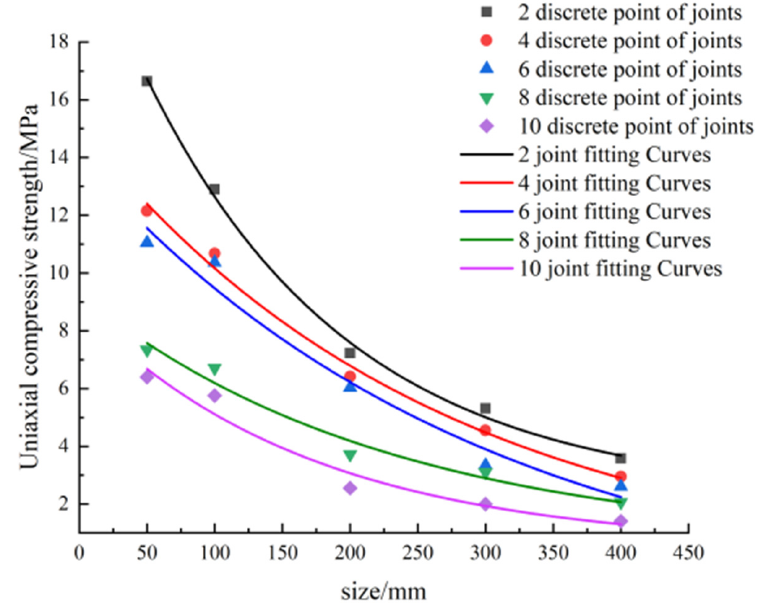
Figure 9. Fitting curves of UCS with different rock sizes.